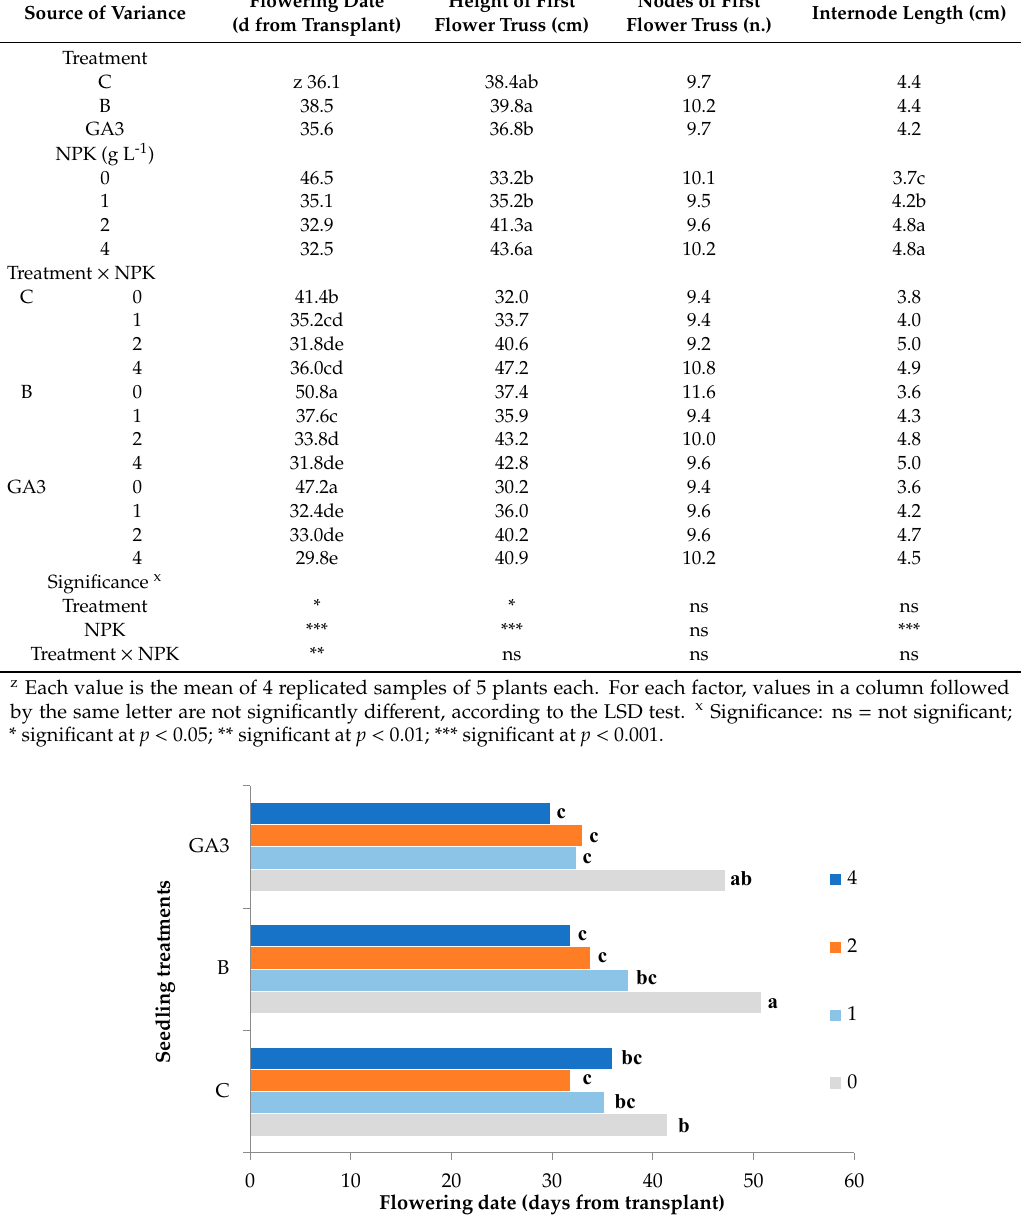
Table 4. E ff ects of the seedling treatments (C, untreated control, B, bacterial biostimulant, GA3, gibberellic acid spray 10 − 5 M) and the nursery fertigation rates (g L − 1 of NPK 20-20-20) on the flowering of Solanum lycopersicum ‘Marmande’ plants grown in soilless cultivation. Flowering Date Height of First Nodes of First Internode Length (cm) Source of Variance (d from Transplant) Flower Truss (cm) Flower Truss (n.) Treatment C z 36.1